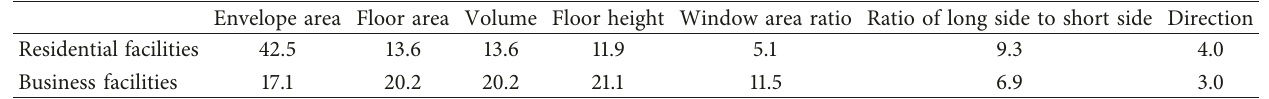
Table 7: Rate of transformation influenced by hierarchy by architectural design elements (%).